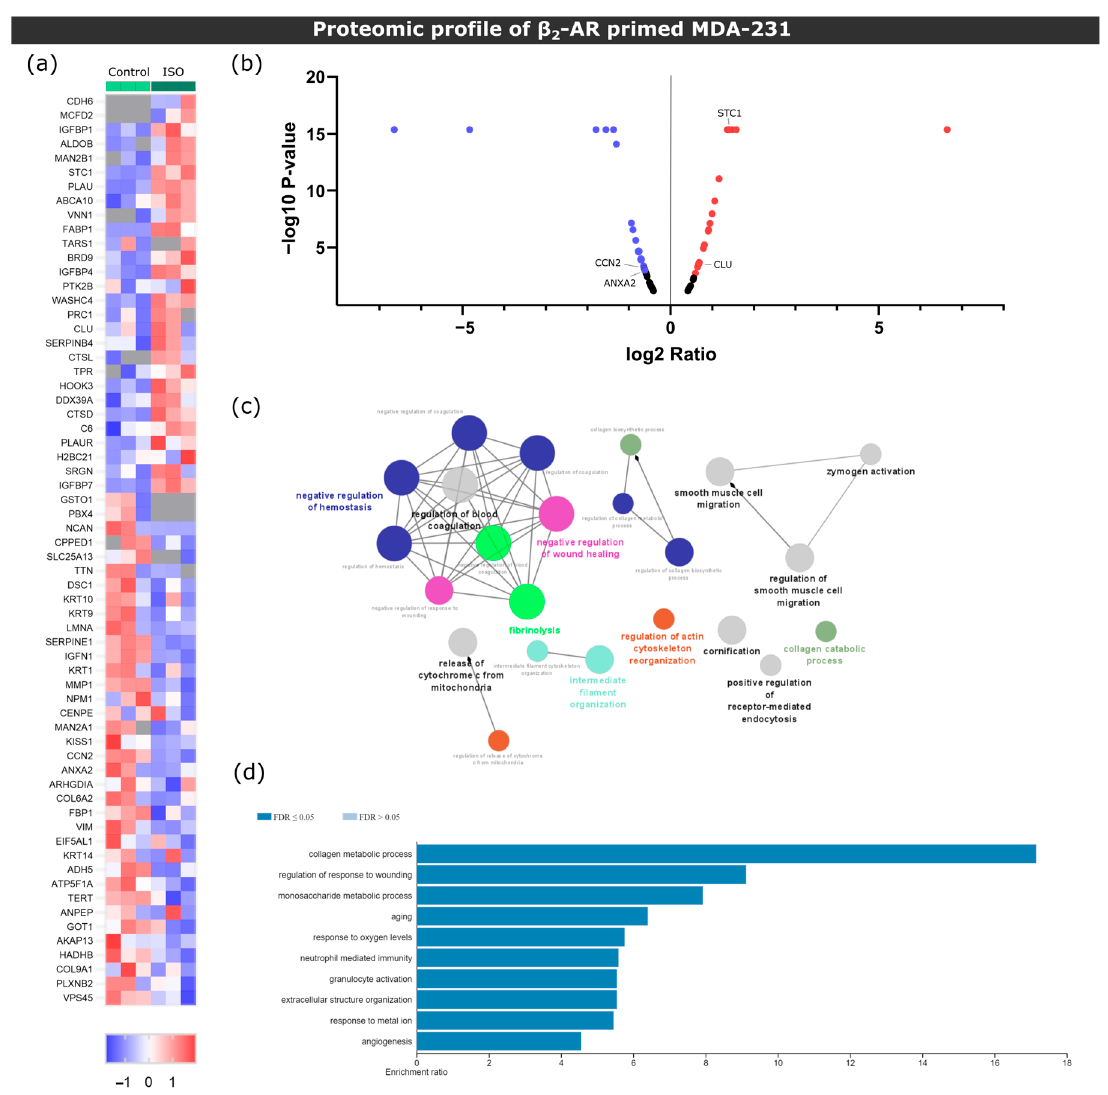
Figure 2. Proteomic screening of MDA-231 conditioned media under β 2-AR activation. ( a ) Heatmap depiction of significantly deregulated proteins found in conditioned medium from control or ISO- treated MDA-231 cells (Student’s t -test, p ≤ 0.05). The ratio of protein abundances was color coded as shown in the legend. Data from three independent samples are shown, one sample per column. Gray cells represent proteins not detected in a particular sample. ( b ) Volcano plot distribution of significantly deregulated proteins. The ratio between protein abundances between MDA-231 cells treated with ISO and control samples are plotted on the X axis, and the p -value is plotted on the Y axis. Red dots represent proteins with a fold change ≥ 1.5, while purple dots represent proteins with a fold change ≤ − 1.5. ( c ) Gene ontology biological process network analysis of differentially expressed proteins in ISO-treated MDA-231 cells. Only networks with p ≤ 0.05 are shown (two- sided hypergeometric test and Bonferroni step-down correction). Different colors illustrate different biological processes, while the size of the nodes is proportional to the statistical significance of each process. ( d ) Significantly enriched biological process terms in the group of deregulated proteins in ISO-treated MDA-231 cells. ORA was used and only processes with a false discovery rate of ≤ 0.05 are